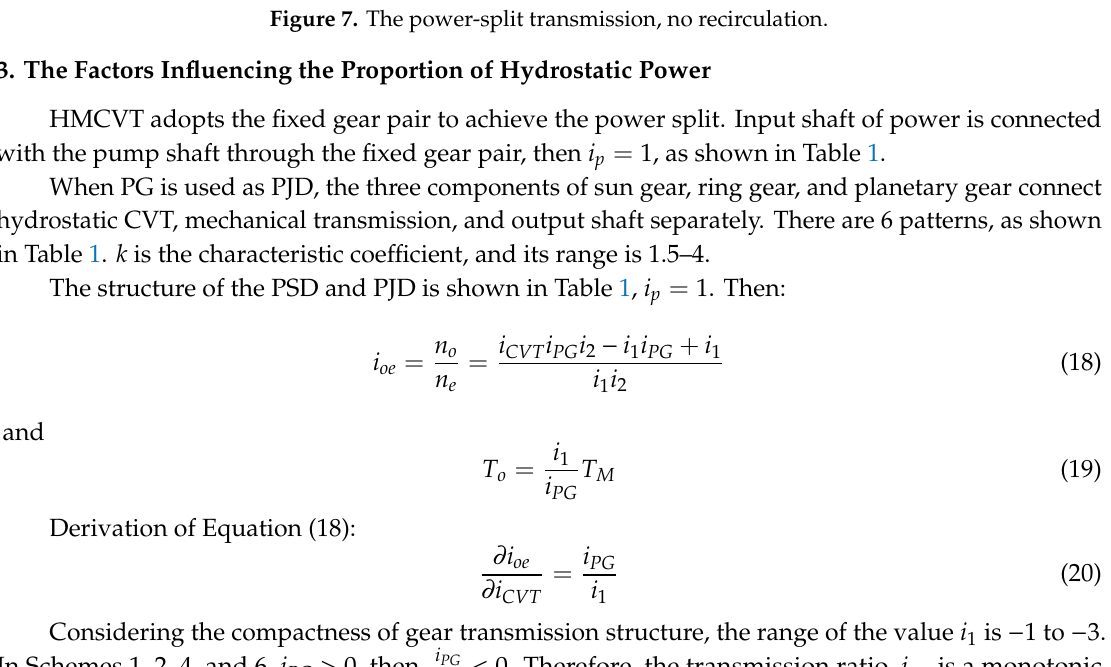
Figure 7. The power-split transmission, no recirculation.